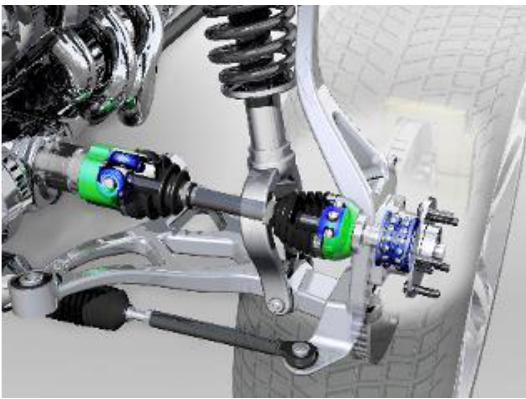
Figure 1. An automotive driveshaft.